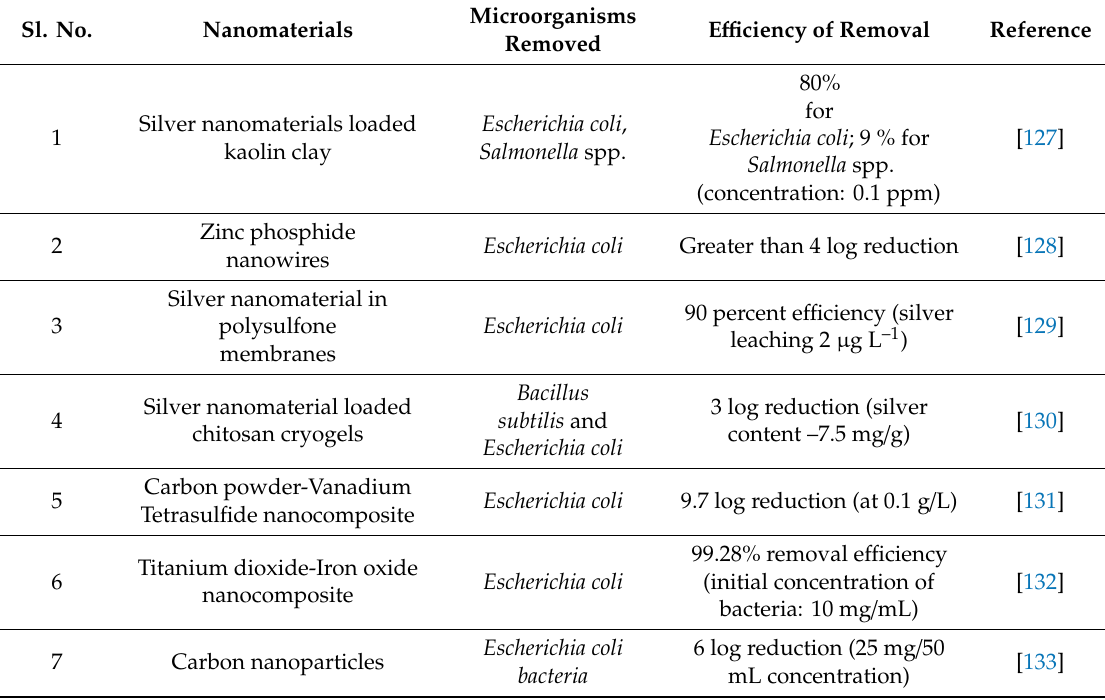
Table 3. Application of nanomaterials for the disinfection as well as bacterial control of water. Sl.